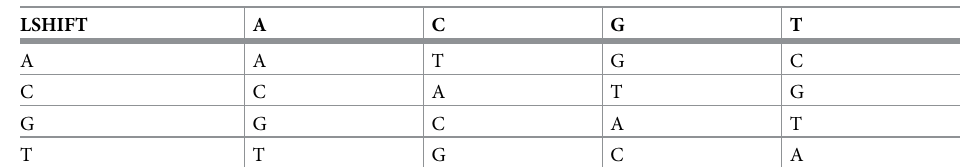
Table 8. DNA shift